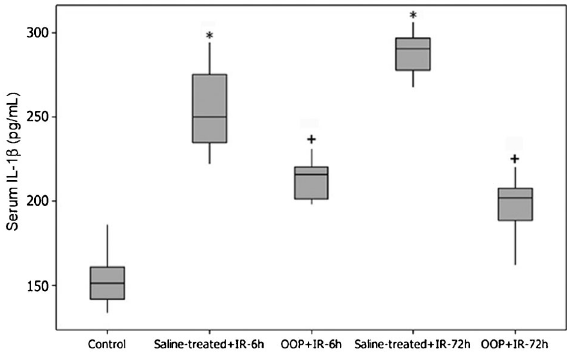
Figure 2. Serum interleukin-1 b (IL-1 b ) levels of control, saline- treated++ionizing radiation (IR), or ozone oxidative precondition- ing (OOP)++IR groups decapitated at 6 or 72 h after irradiation. Each group consisted of 8 rats. *P=0.001 compared to control group; + P=0.001 compared to saline-treated group (Mann- Whitney U-test).